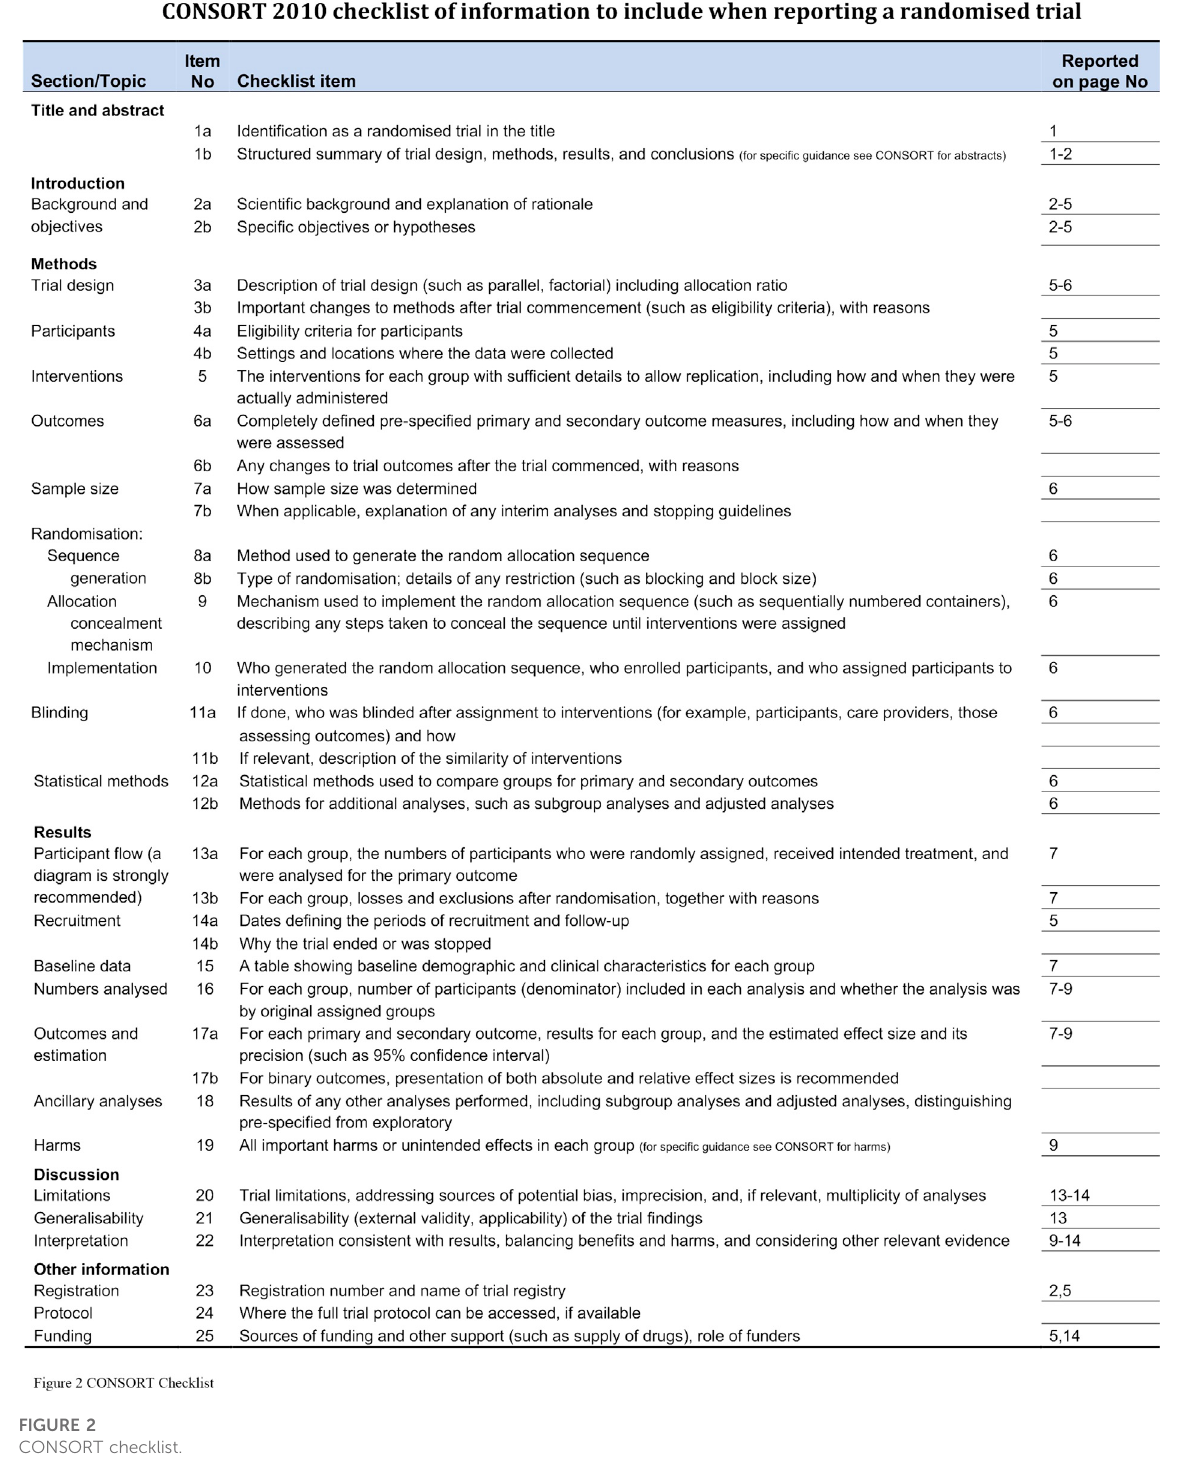
FIGURE 2 CONSORT